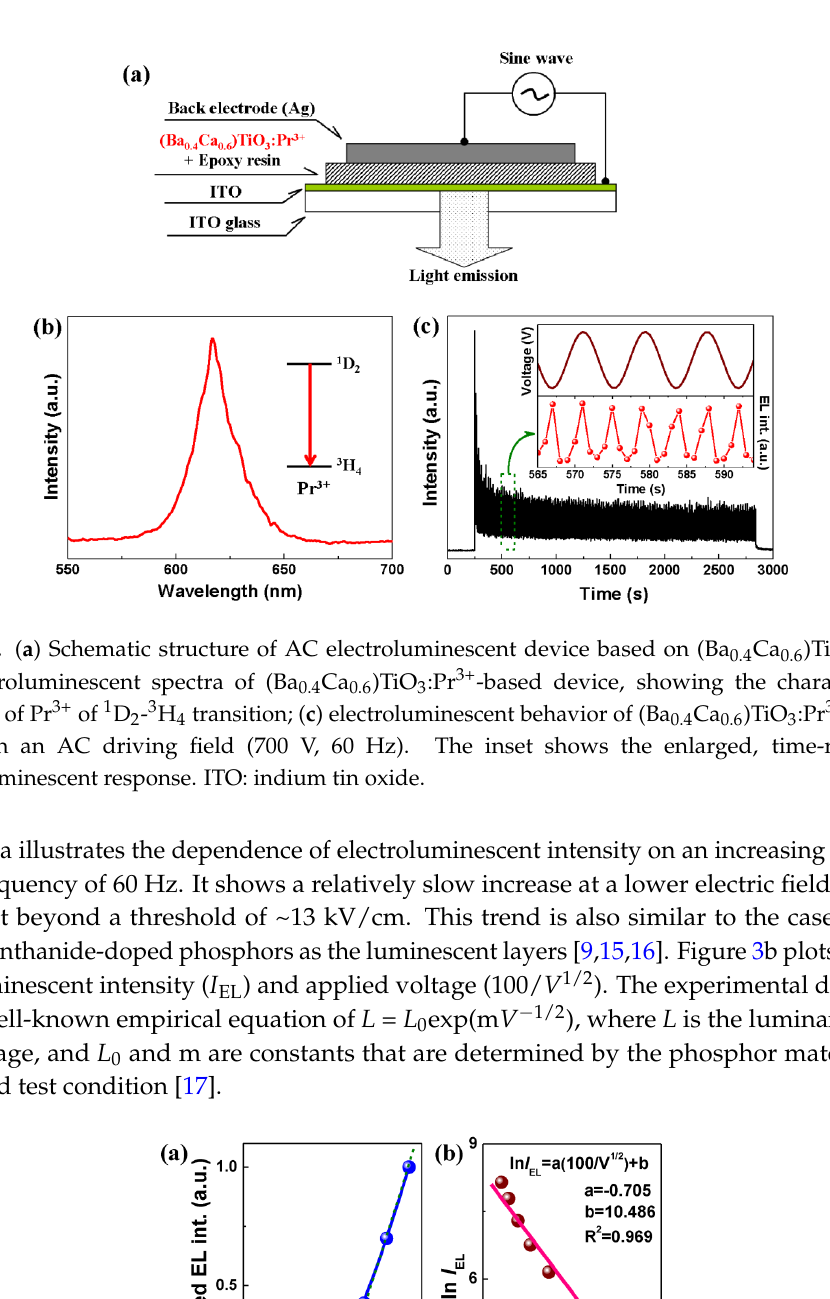
Figure 1. ( a ) XRD pattern of (Ba 0.4 Ca 0.6 )TiO 3 :Pr 3+ powders; ( b ) backscattered-SEM picture of (Ba 0.4 Ca 0.6 )TiO 3 :Pr 3+ pellet.